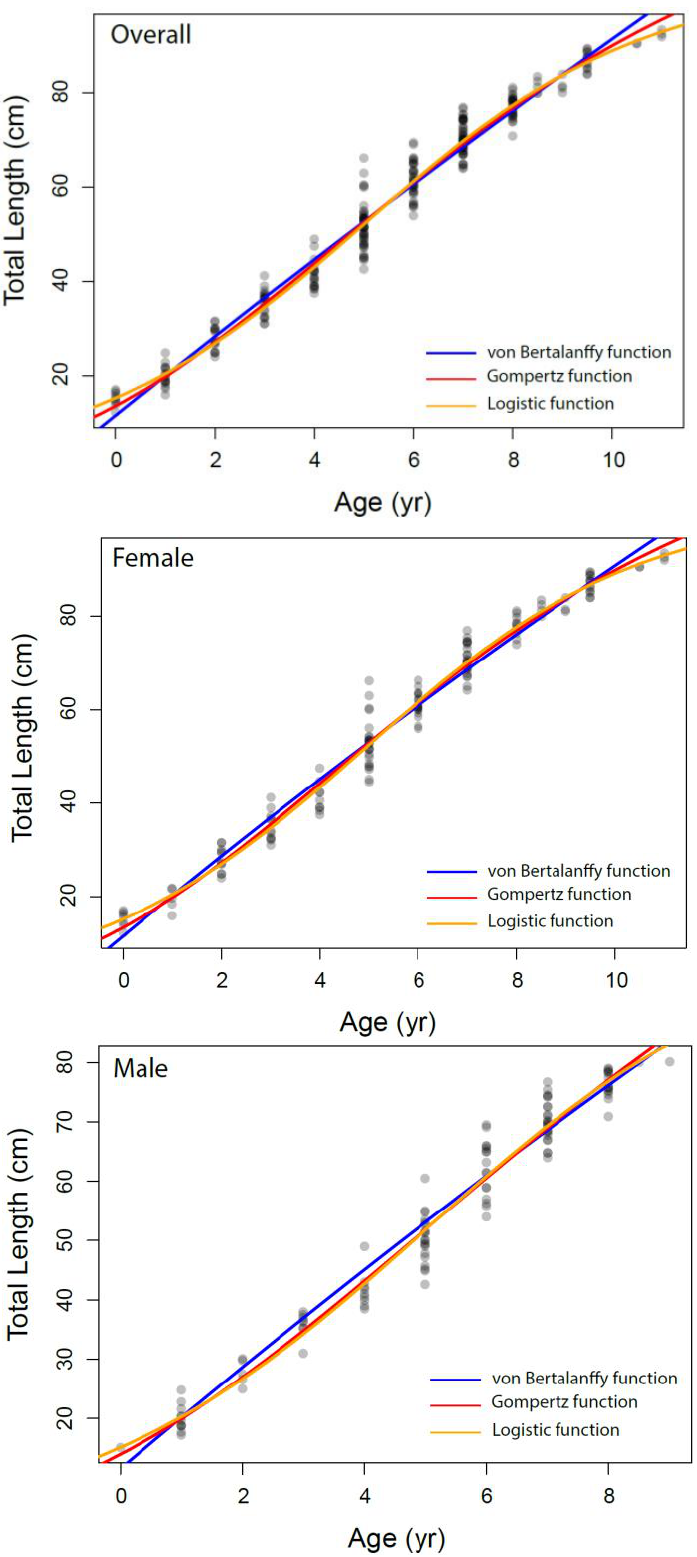
Figure 6. The different growth models fitted to the data of Dipturus oxyrinchus inhabiting the Northeastern Mediterranean Sea.